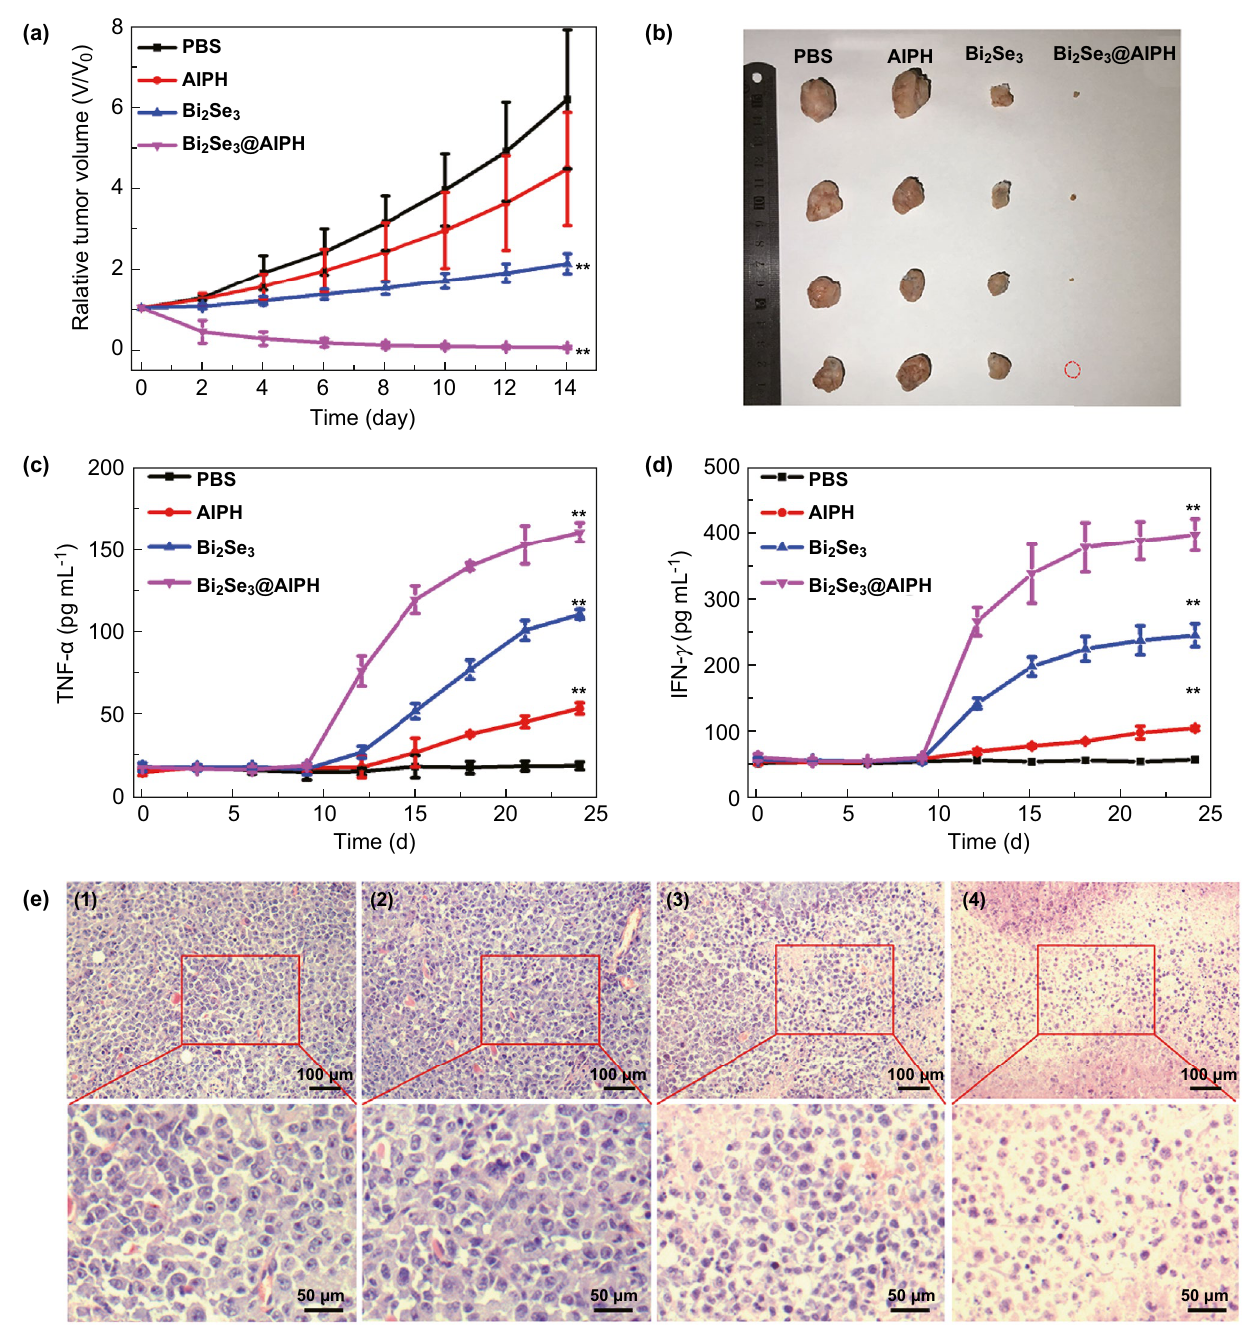
Fig. 7 a Relative tumor volume changes in 14 days. b Photographs of the excised tumors after 14 days of treatment. c The TNF-α and d IFN-γ level during the treatment measured every 3 days. The vaccination of H22 tumor cells marked as 0 day, and the treatment starts at day 9. e Images of tumor sections by H&E staining. * p < 0.05, ** p <